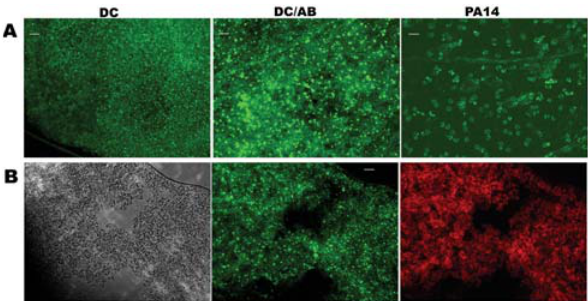
Figure 3. Wide angle micrographs of membrane permeabiliza- tion in seedlings infected with different microbes. Wide angle microscopy of seedlings sytox green staining in green fluorescence channel. (18X magnification). Seedlings were stained 3 dpi with membrane impermeable dye Sytox green (SG) and imaged in transparent bottom wells of 96 well plates.